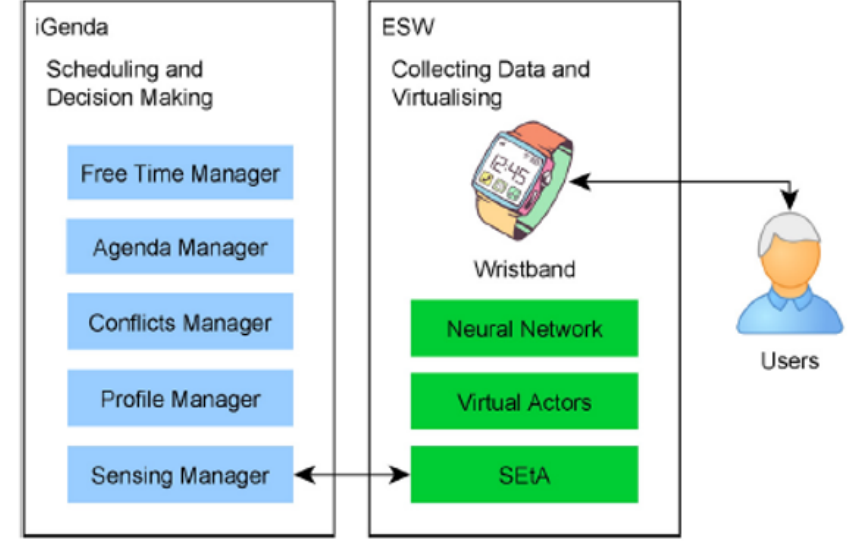
Figure 1 . Overview of the smart wristband with iGenda (Costa et al., 2019 [15]) . Figure 1. Overview of the smart wristband with iGenda (Costa et al., 2019